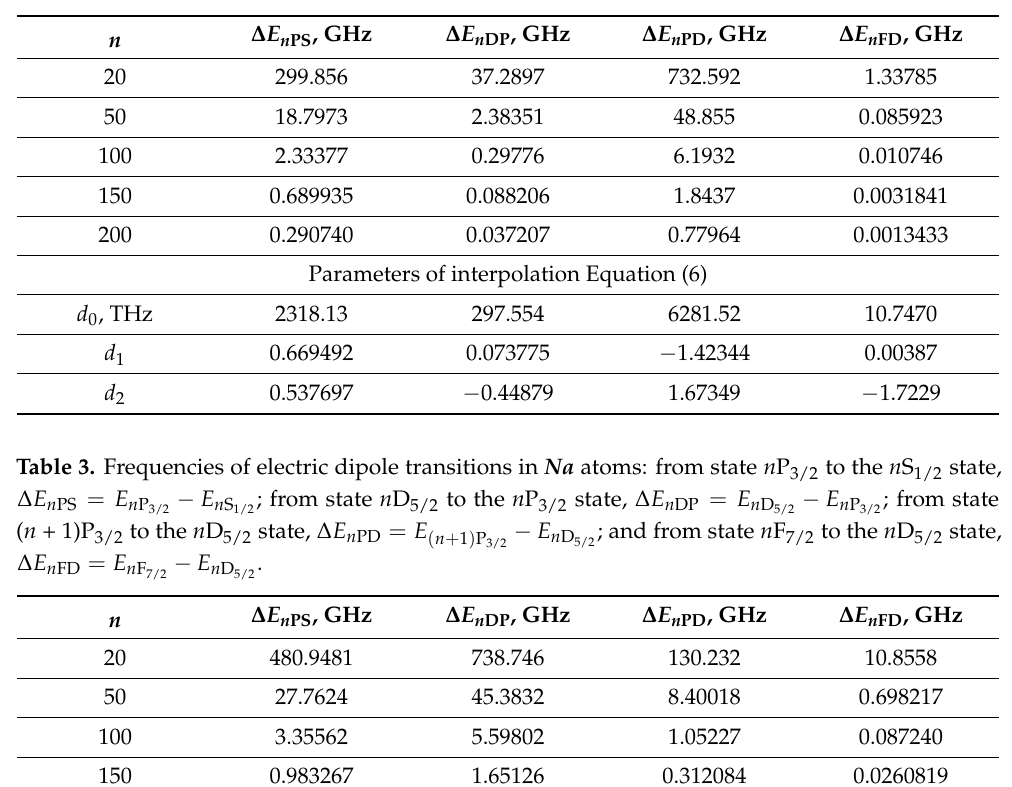
Table 2. Frequencies of electric dipole transitions in Li atoms: from state n P 3/2 to the n S 1/2 state, ∆ E = E − E n PS n P 3/2 n S 1/2 ; from state n D 5/2 to the n P 3/2 state,